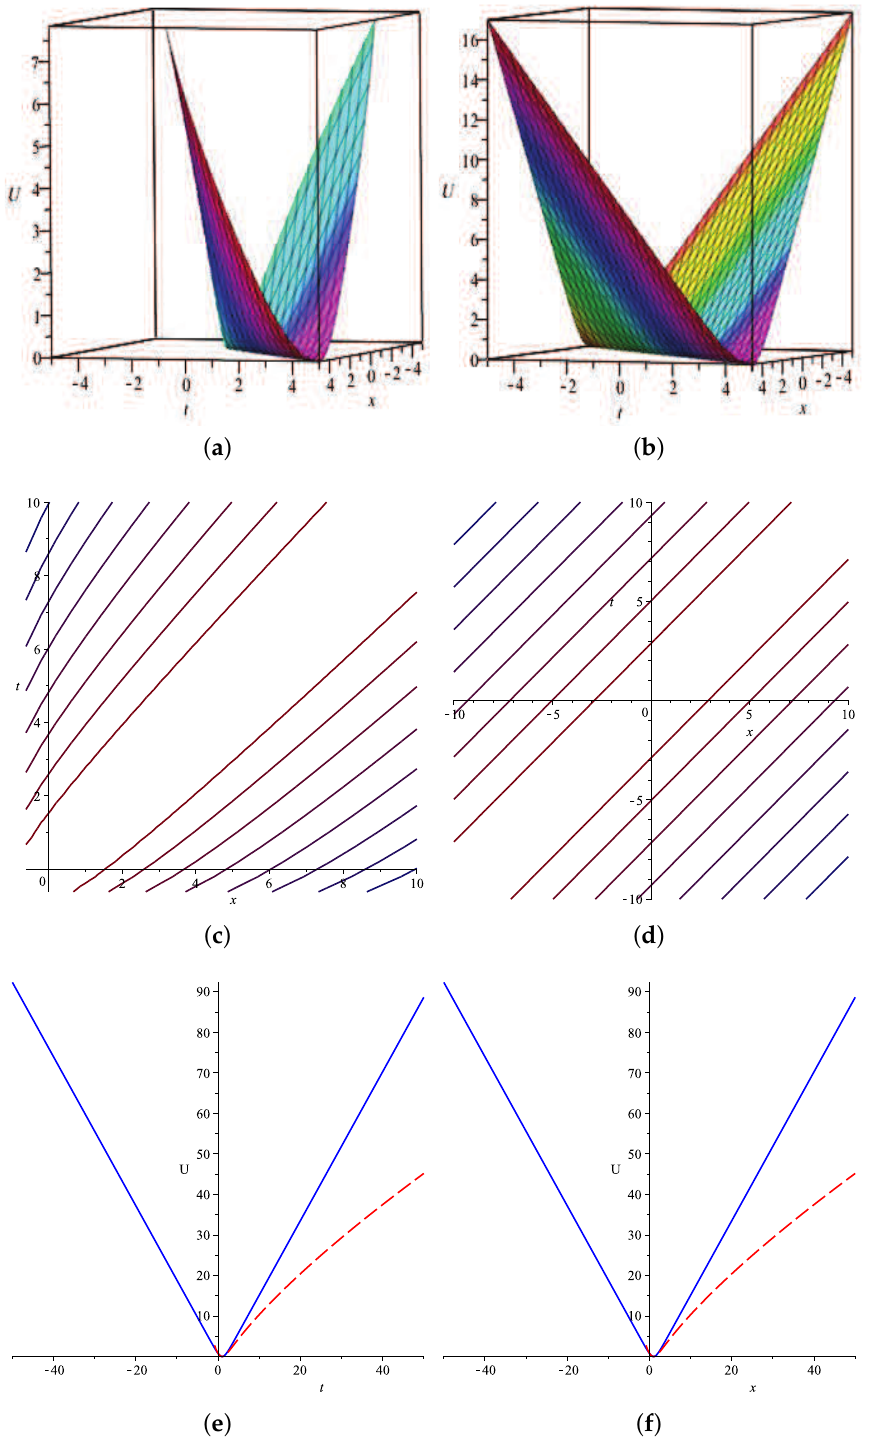
Figure 2. In ( a ), the graph of Equation (36) is given with β = 0.75, whereas, in ( b ), the graph of Equation (37) is given with β = 0.75 and α = 1. In ( c , d ), the 2D contours corresponding to the graphs ( a , b ) are given. ( e , f ) show 2D comparison of both solutions for x = 1 and t = 1,